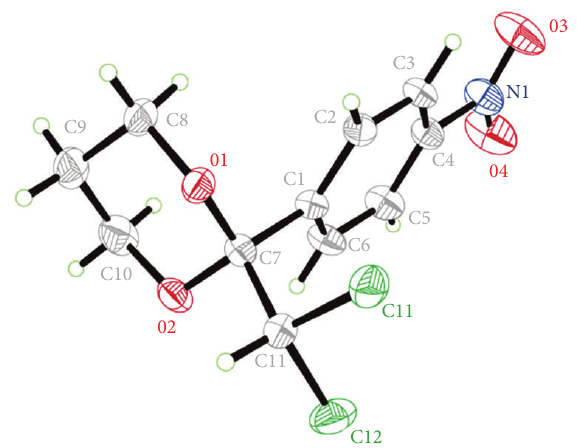
Figure 1: Molecular diagram of compound 4 showing 30% probability ellipsoids.